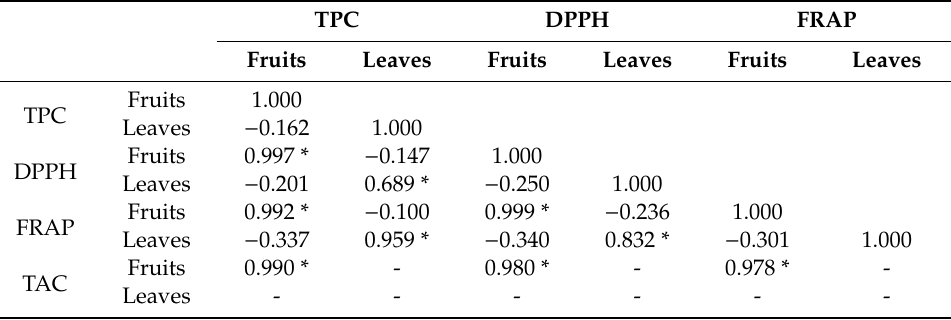
Table 2. Correlation matrix for mulberry fruits and